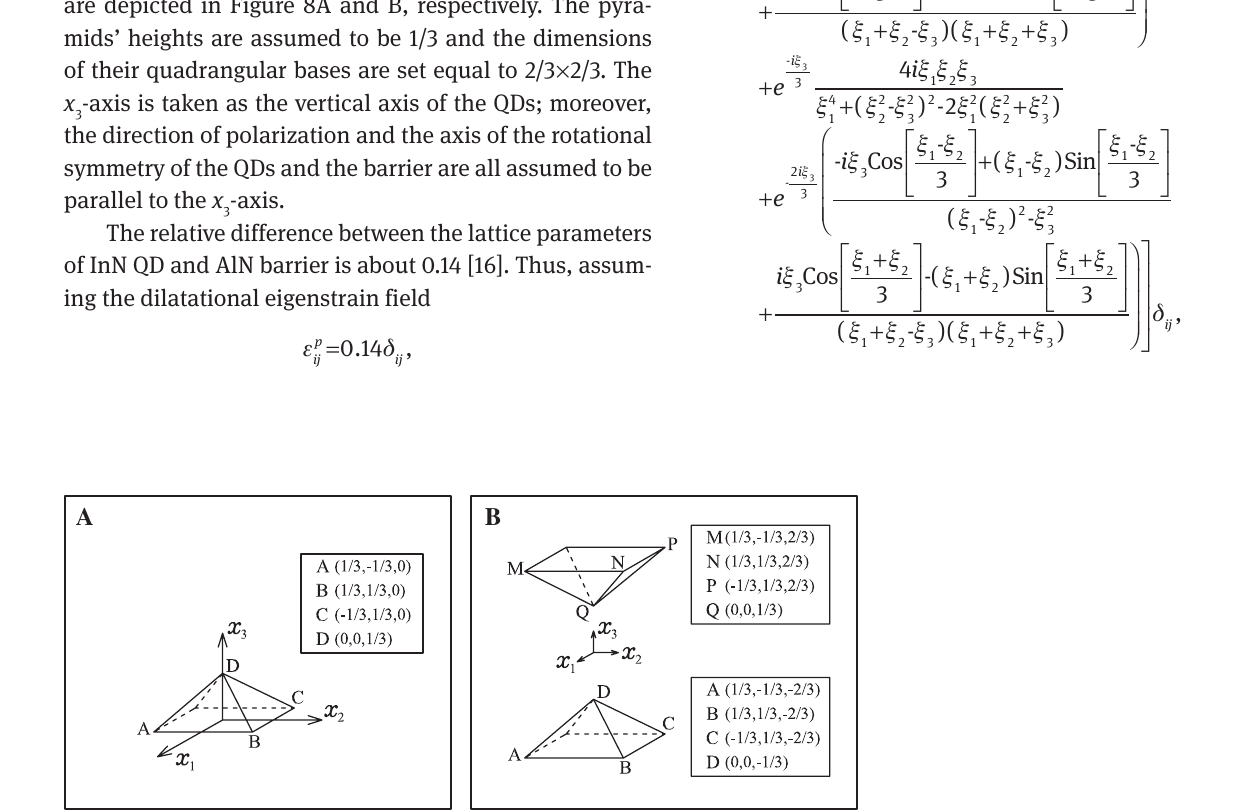
Figure 8 Geometries of (A) a single InN QD and (B) two interacting InN QDs, within AlN barrier.